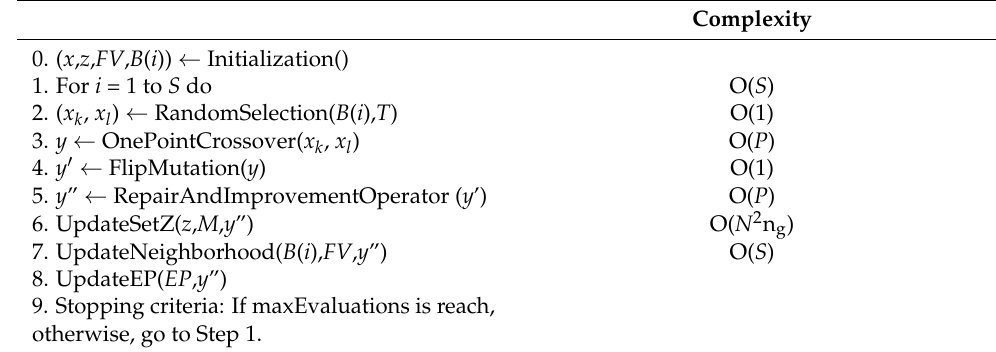
Table A9. MOEA/D time complexity analysis.